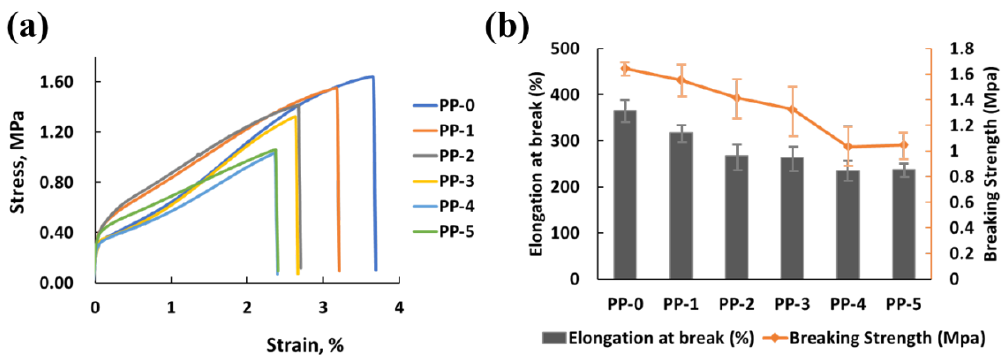
Figure 8. ( a ) Stress–strain behavior, and ( b ) trend of elongation at break and breaking strength of e-spun PP fibers.